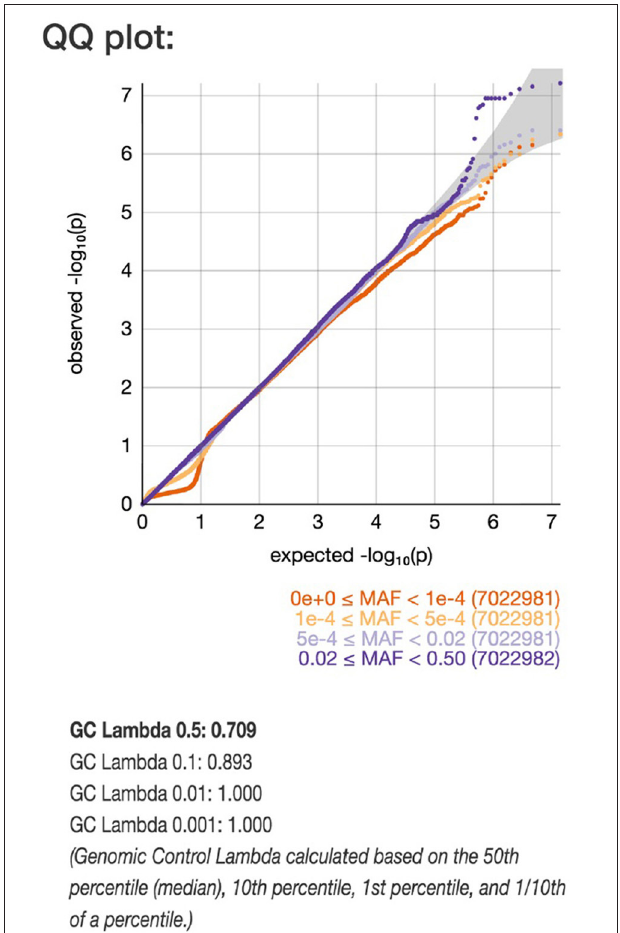
FIGURE 4 | QQ plot of genome-wide single-variant association analyses in the UK Biobank cohort. Markers are stratified by MAF between 0.5–0.02 and 5 × 10 − 4 − 1 × 10 − 4 shown with light blue and dark blue. Dots indicate observed P -values (–log10[ P -value]) compared with those expected by chance. The gray line indicates the identity (no association) including the corresponding 95% CI under the null hypothesis (no